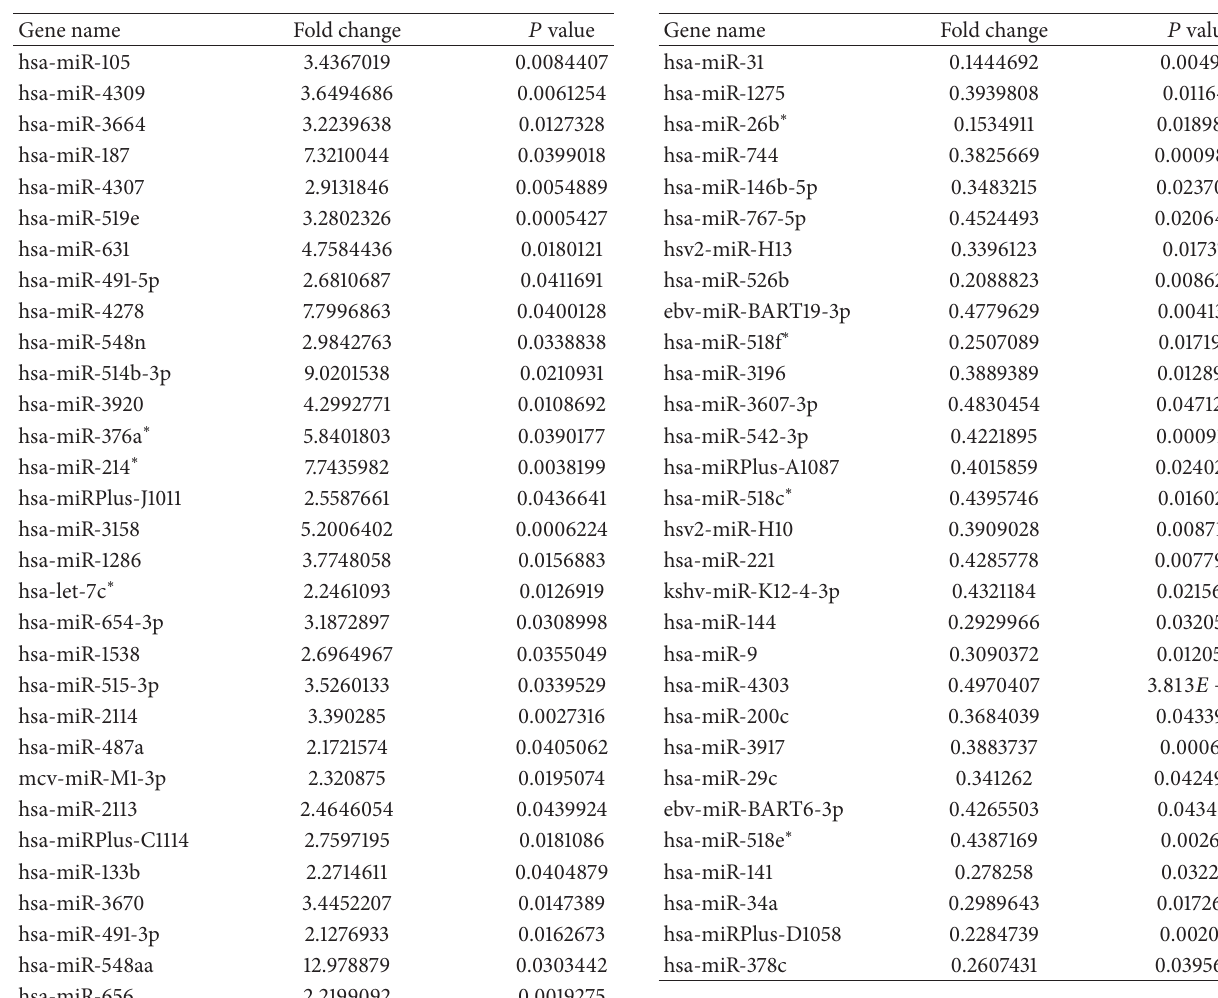
Table 1: List of upregulated expression miRNAs in gastric cancer. Table 2: List of downregulated expression miRNA in gastric